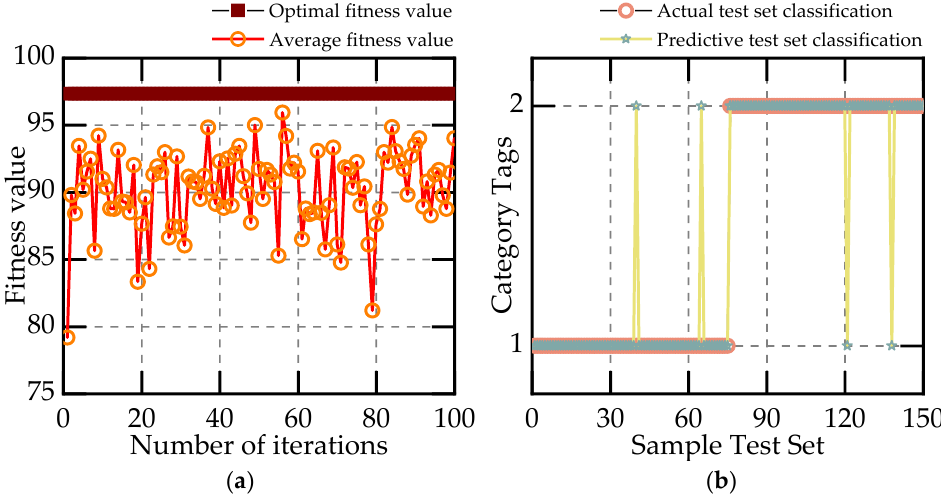
Figure 11. Classification graph of PSO-SVM classifier. ( a ) Adaptability curve. ( b ) Classification chart.